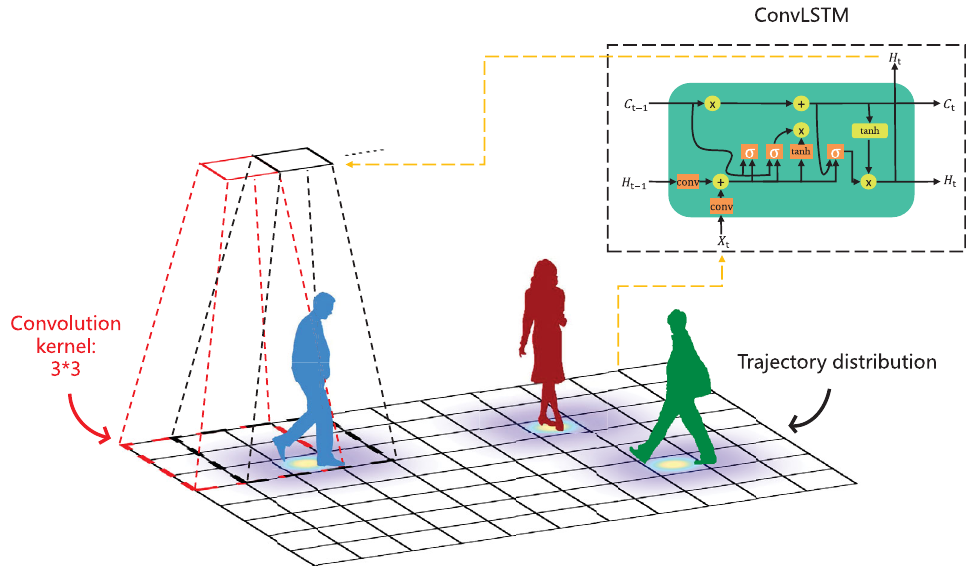
Fig. 4 The convolution layer added to LSTM gives the model the ability to extract spatial features. Convolution operations on the trajectory distribution enable our method to model human–human interactions more intuitively and